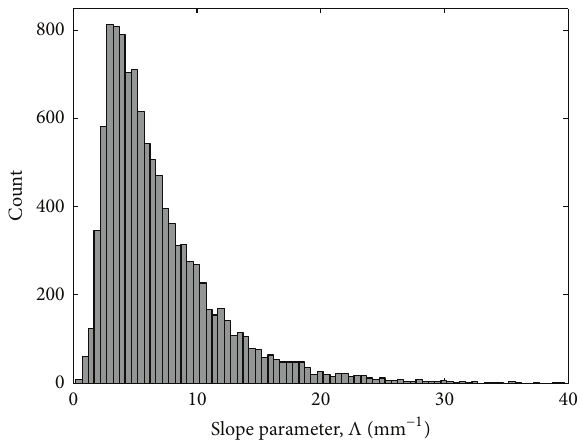
Figure 7: Histogram of estimated slope parameter Λ for Gamma model.